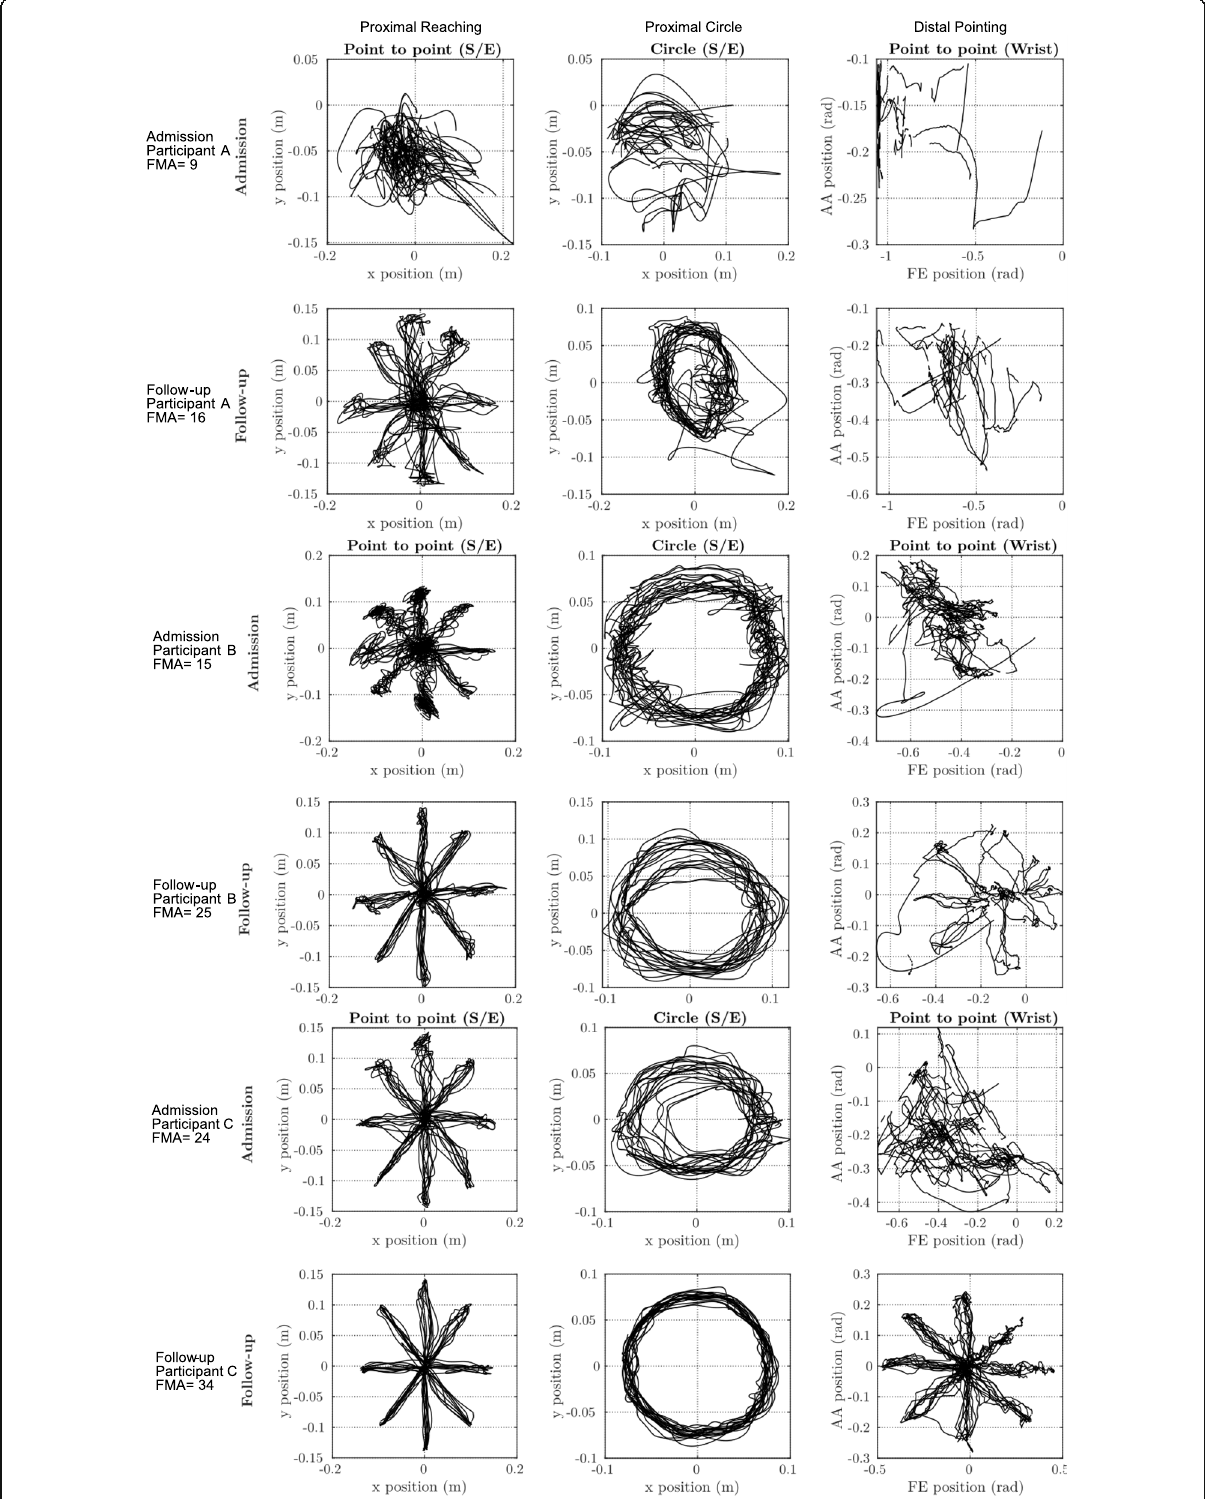
Fig. 3 Unassisted proximal and distal movement attempts of three representative stroke participants at study baseline and